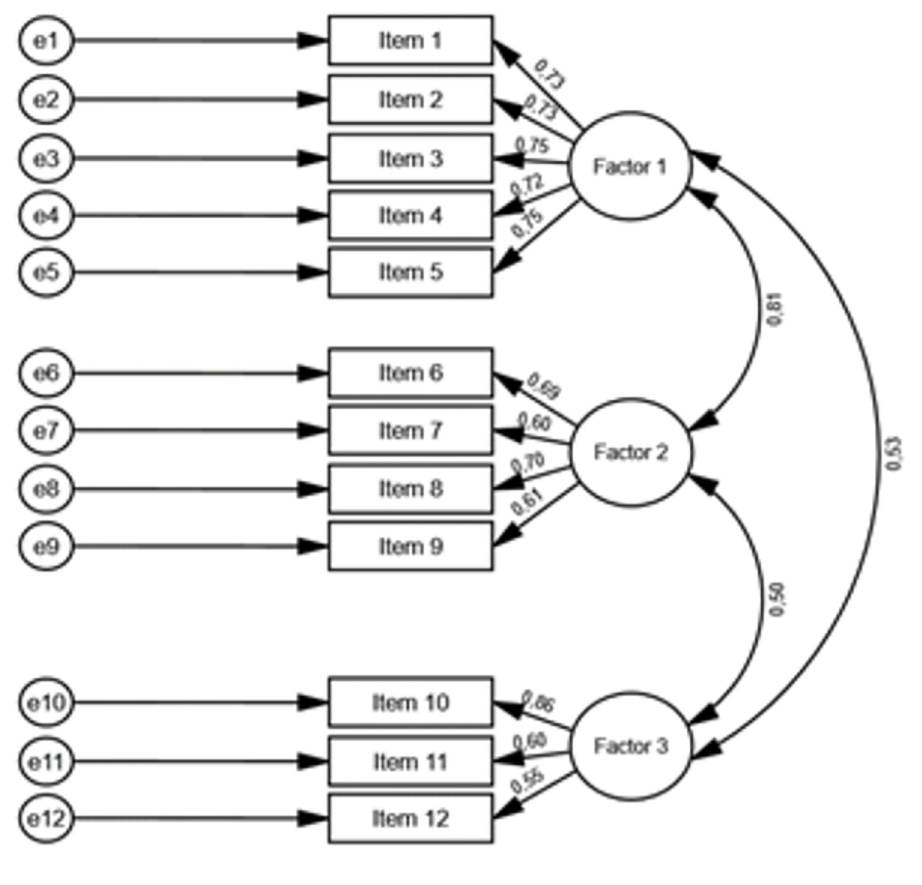
Fig 3. Confirmatory factor analysis structure and regression/correlation values (random sample b; n = 1735).